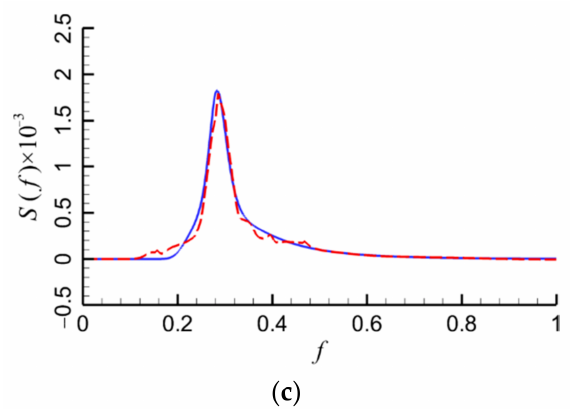
Figure 6. Wave energy spectrum comparison for irregular waves: ( a ) case 2; ( b ) case 4; ( c ) case